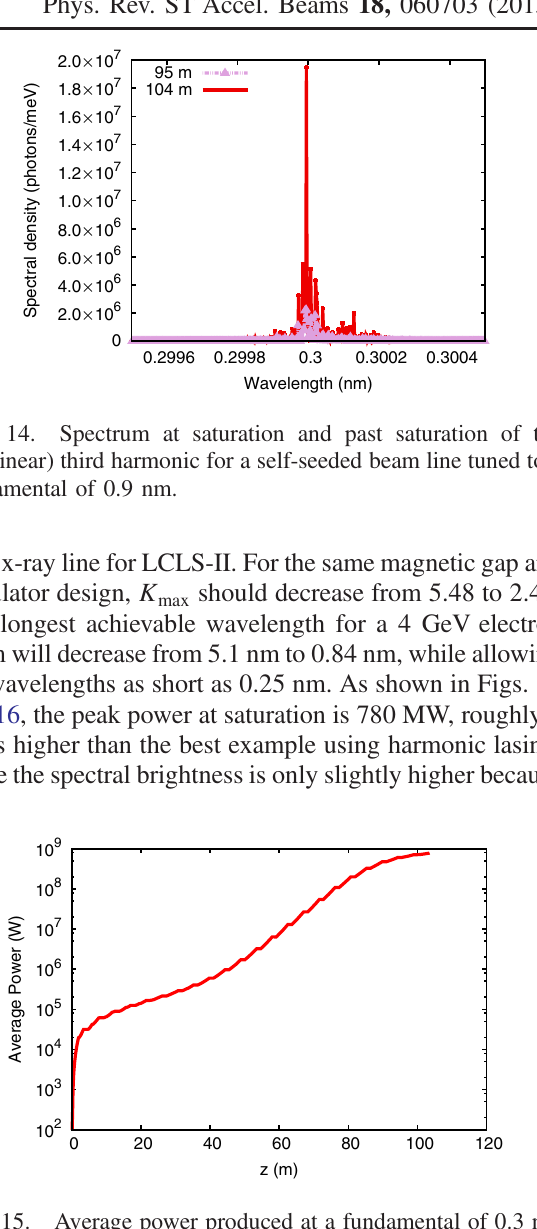
FIG. 15. Average power produced at a fundamental of 0.3 nm using an undulator period of 26 mm.